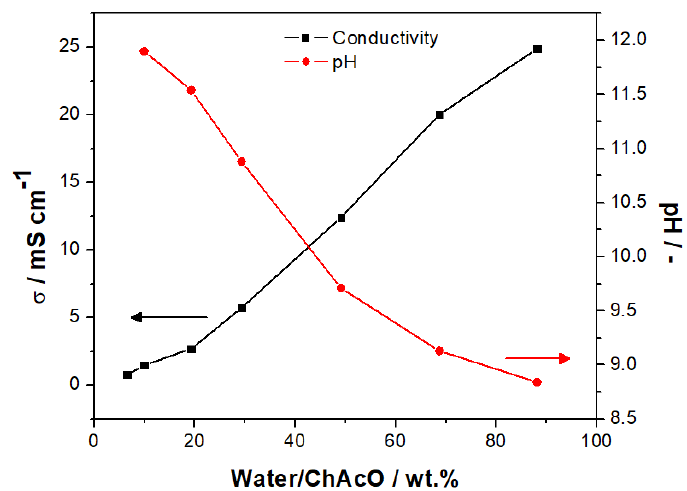
Figure 5. Photos of contact angle (CA) of 5 µL droplets of ( a ) ChAcO + 30 wt.% H 2 O + 0.01 M ZnAcO and ( b ) 7 M KOH after 30 min on different GDE substrates.